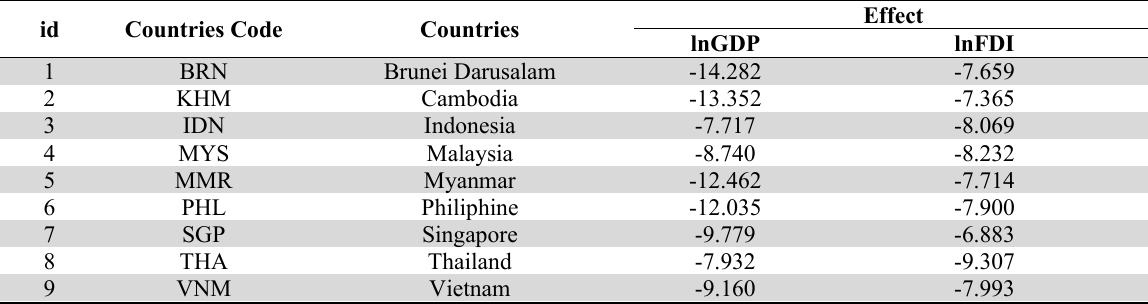
Country value (individual fixed